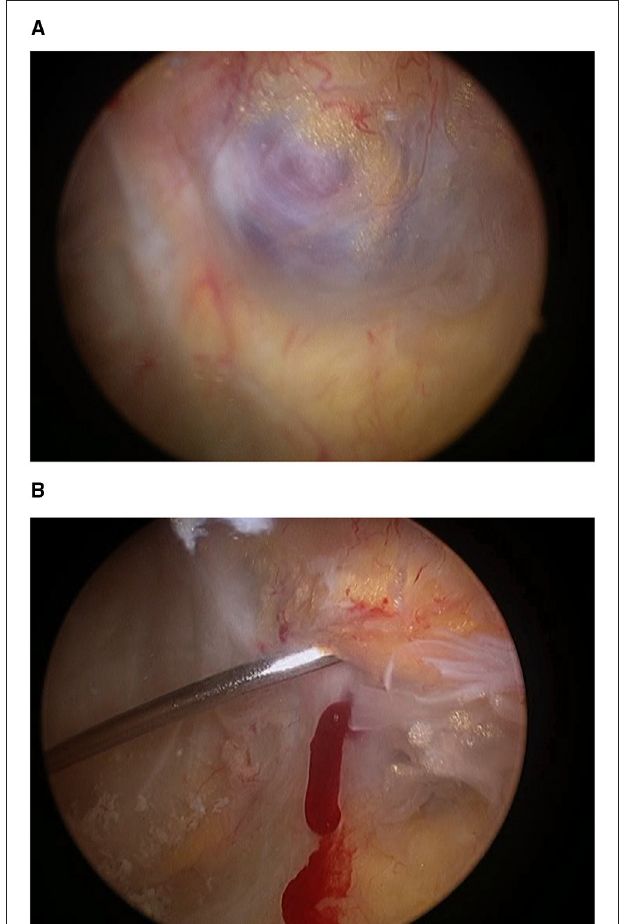
FIGURE 8 | Case 4 posterior compartment SH arthroscopic view and puncture. (A) . Arthroscopic view of the synovial haemangioma via the anterolateral portal, showing a pale bluish vascular lesion in the synovium lining the posterior capsule, just behind the PCL (1 × 0.5 × 0.5cm). (B) Puncture of the synovial tumor produced acute bleeding that differentiated it from other tumors, such as